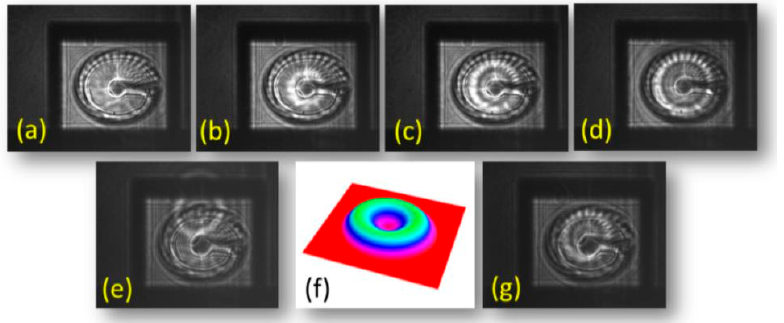
Figure 7. Configuration Com 2 : a torus-like phase map (SLM, f ) was used to generate a flexible ring focus on a spiral phase plate (SPP, diameter 2.9 mm, distance SLM-SPP: 15.5 cm, angle of incidence: 21°, distance between SPP and detector plane: 5 cm). By varying radius ( a – d ) and decenter ( e , g ), the optimum performance was approximated ( c ).